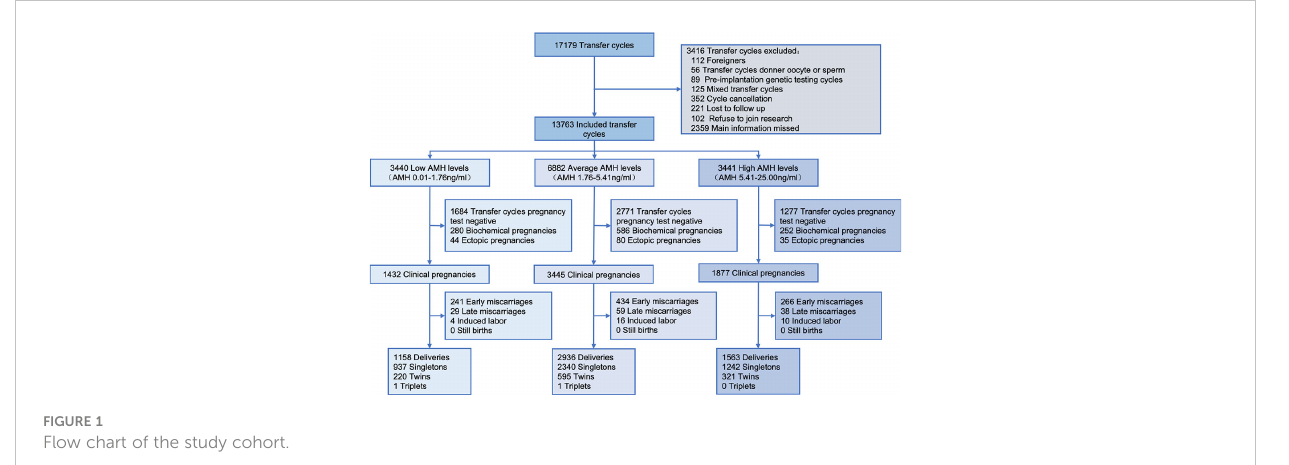
FIGURE 1 Flow chart of the study cohort.